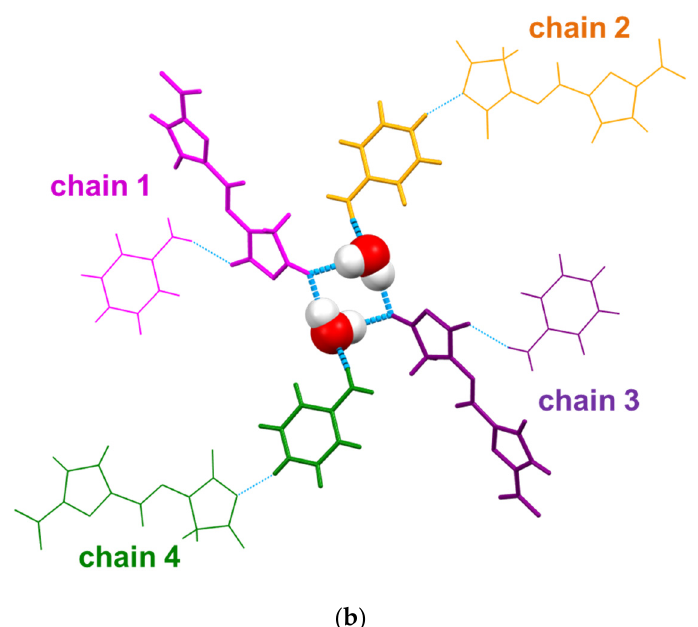
Figure 2. Crystal packing of the [NFT+4AmPy+H 2 O] salt (1:1:1): ( a ) a twisted zigzag chain of NFT-4AmPy dimers; ( b ) water molecules mediate the hydrogen bonds between chains of NFT and 4AmPy.